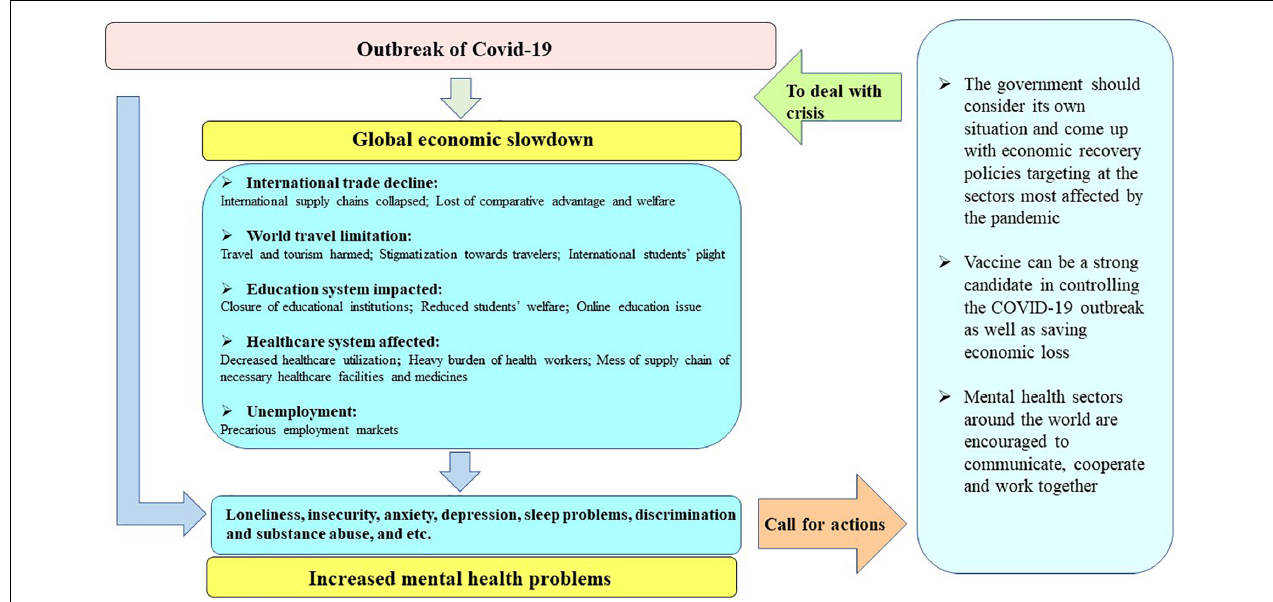
FIGURE 2 | Summary flow